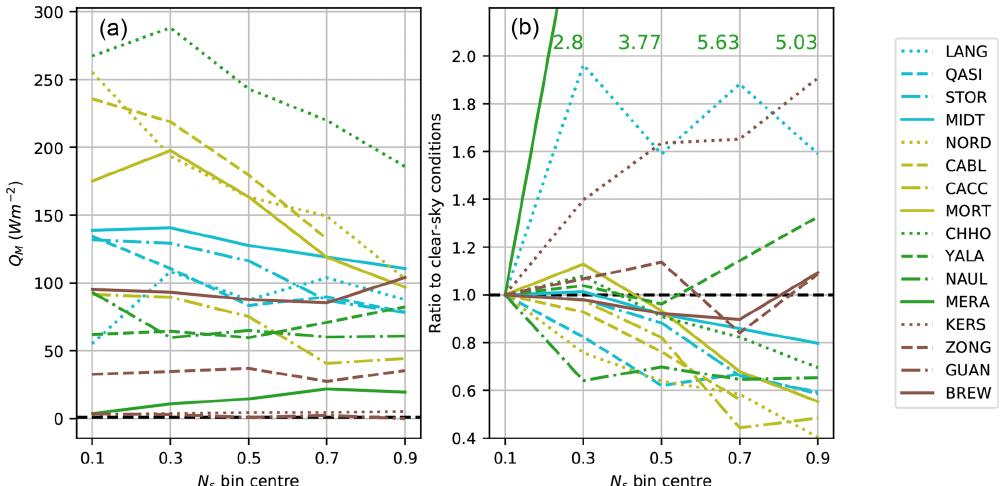
Figure 10. (a) Average melt-season Q M for different cloud conditions ( N ε ). (b) As for (a) shown as a fraction with respect to clear-sky conditions ( N ε (cid:53) 0 . 2). Note that GUAN is excluded from (b) due to insufficient data points and that for clarity some points for MERA are shown as text within the